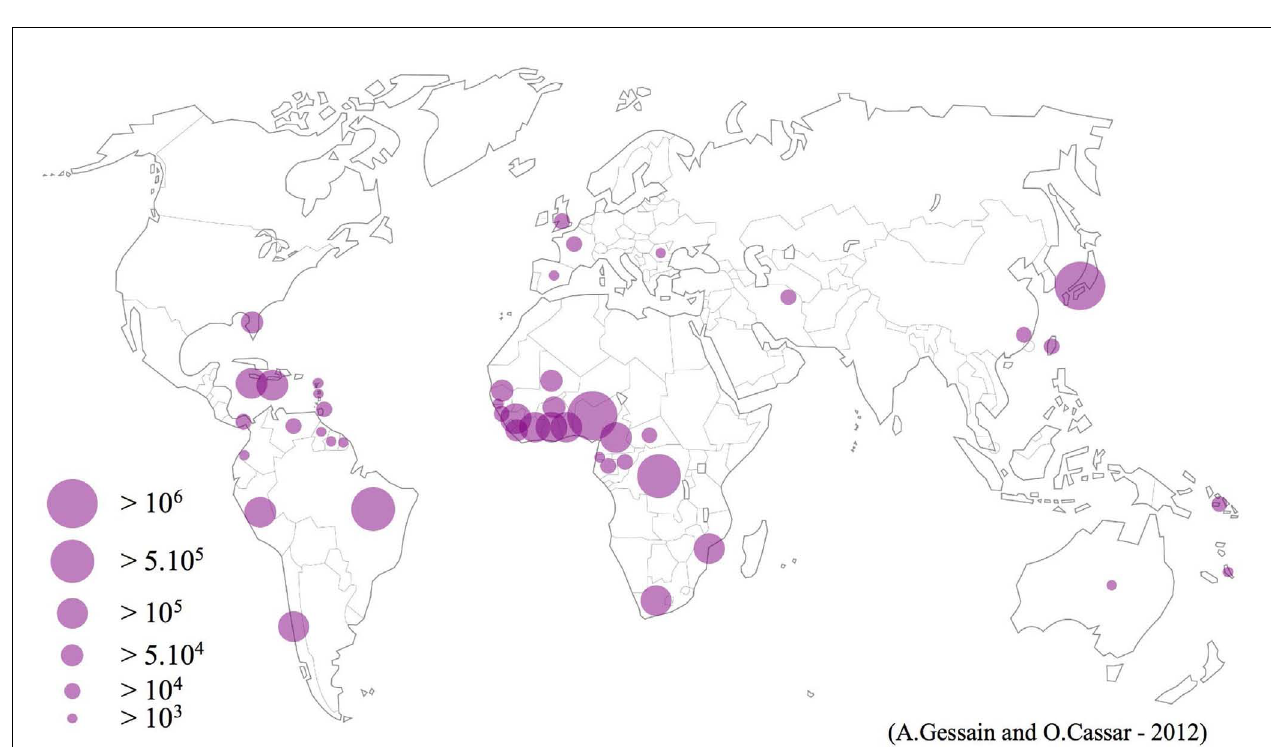
women and/or blood donors and/or different adult populations. In few countries, HTLV-1 endemic areas are limited to residents of certain regions such as Mashad in Iran,The Fujian Province in China,Tumaco in Colombia and Central